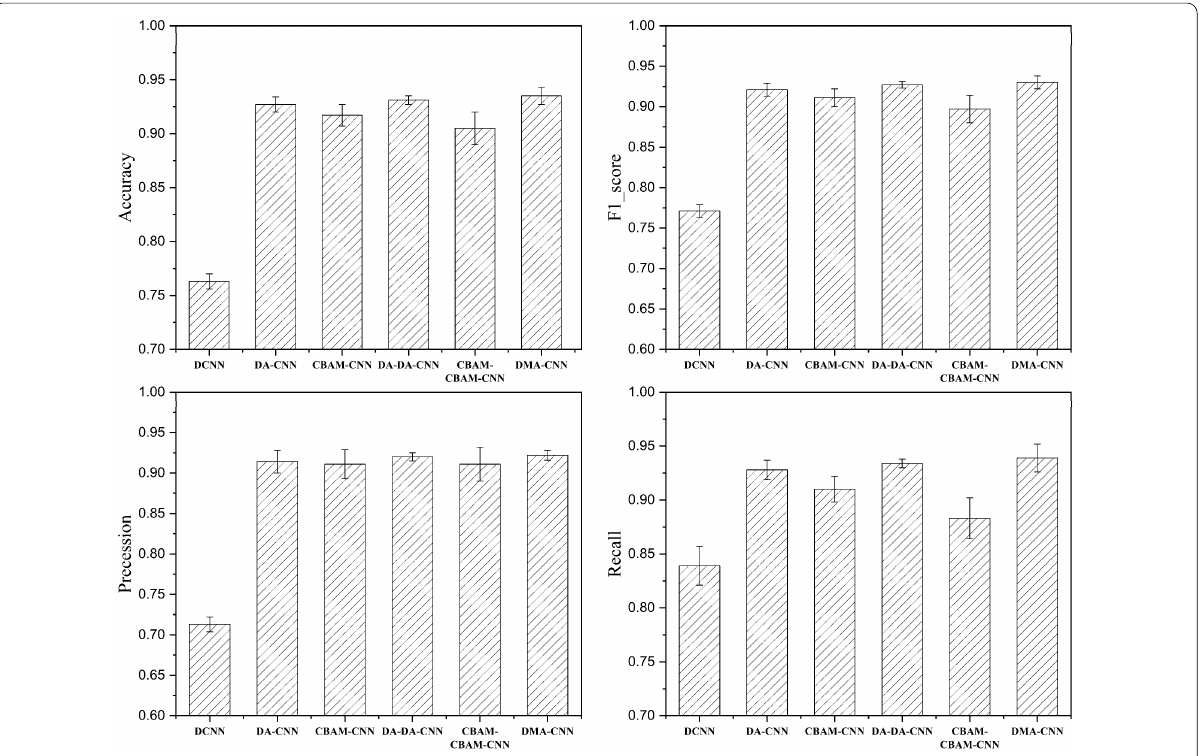
Figure 6 Experimental